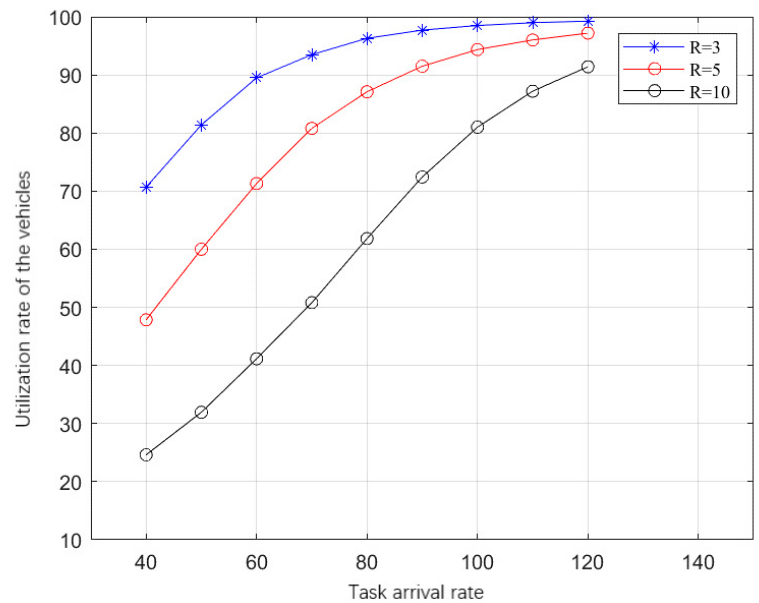
Figure 8. The curve of the vehicle utilization rate with the task arrival rate.